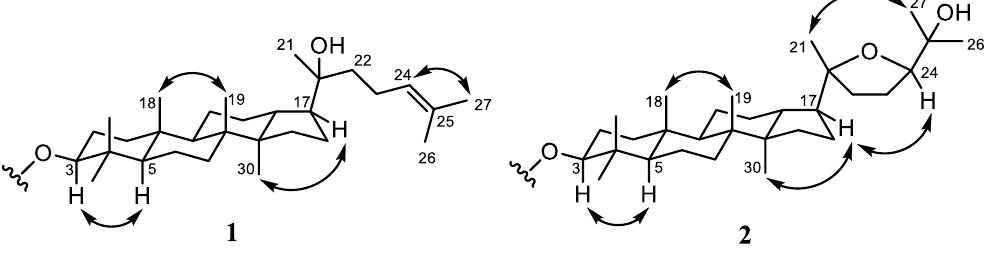
Figure 2. Selected HMBC and 1 H – 1 H COSY correlations for 1 and 2 . 3 β -oleate-20 S ,24 S -epoxy-25-hydroxydammarane ( 2 ) was obtained as a colorless oil.